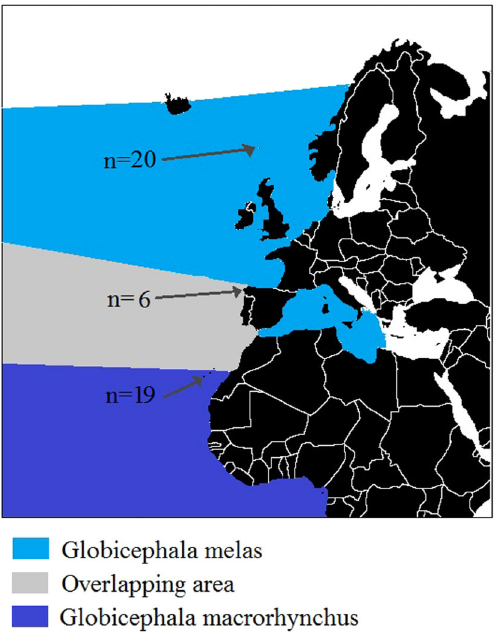
Figure 1. Pilot whale NE Atlantic distribution and sampling areas. Faroe Islands (n=20), Galicia region (n=6) and Canary Islands (n=19).